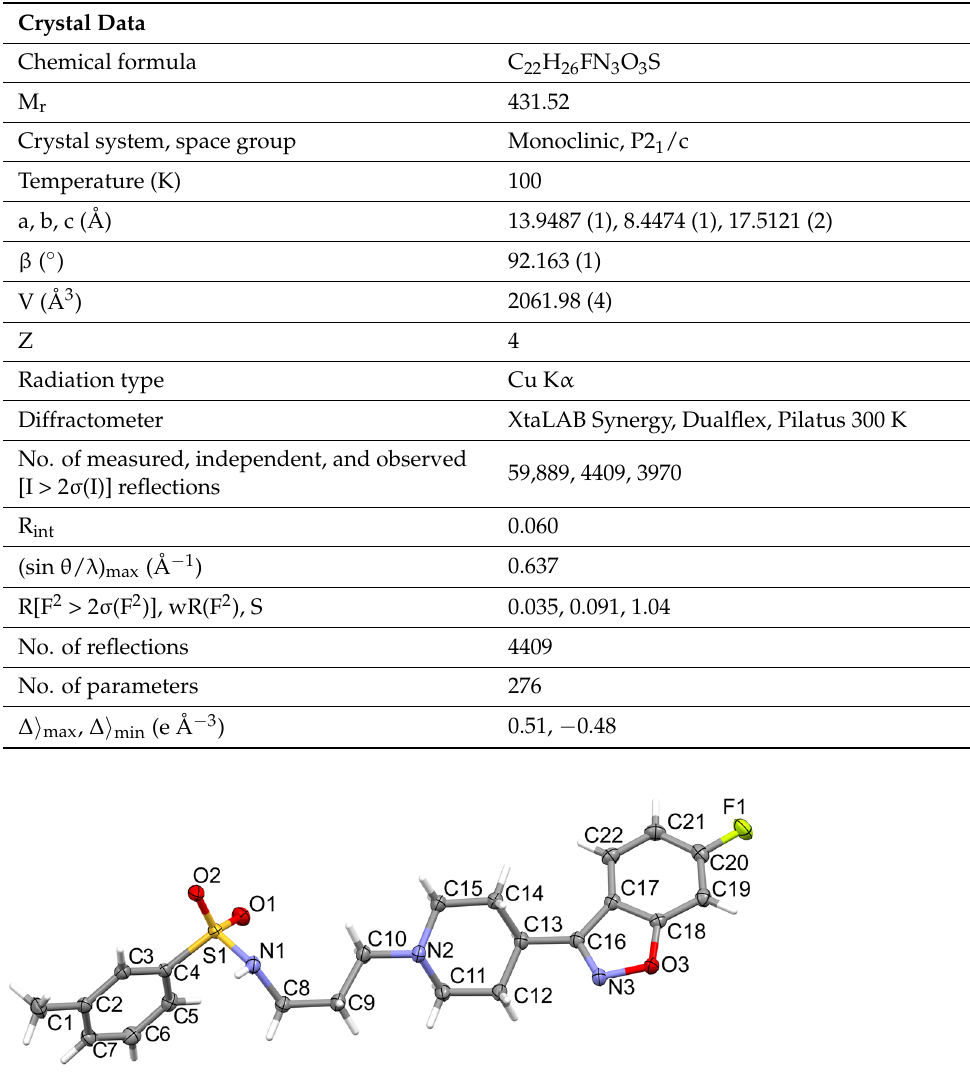
Figure 1. The molecular structure of MBS including the atom-labelling scheme. Displacement ellipsoids are drawn at the 50% probability level and H atoms are shown as small spheres of arbitrary radii.